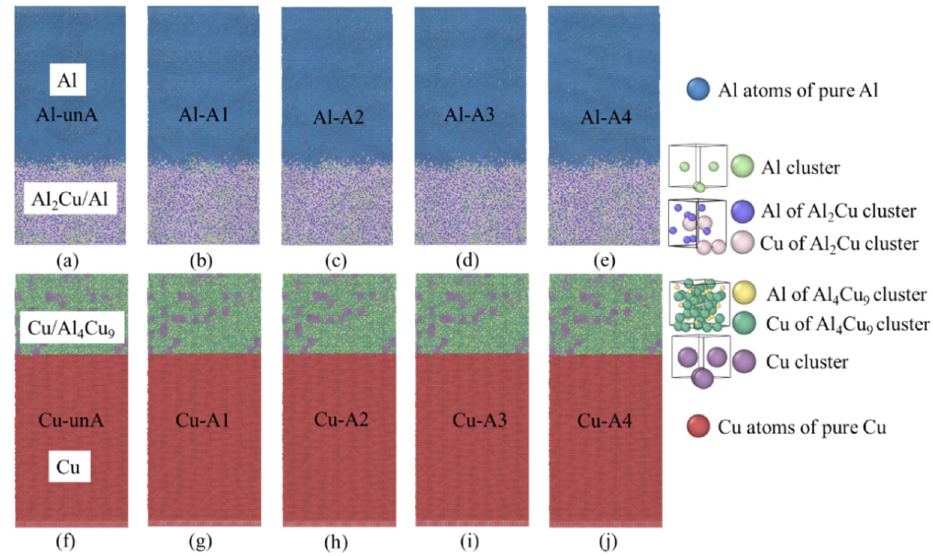
Figure 8. The constructed Al 2 Cu–Al interfacial structures ( a – e ) and Cu–Al 4 Cu 9 interfacial structures ( f – j ) before annealing and annealed at different temperatures. ( f – j ) before annealing and annealed at different temperatures.